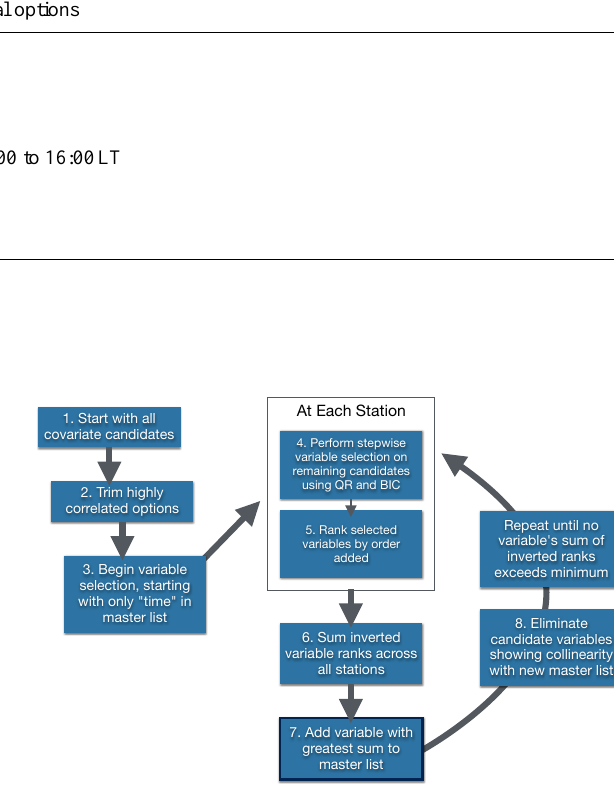
Figure 3. Flowchart of variable selection procedure described in Sect.